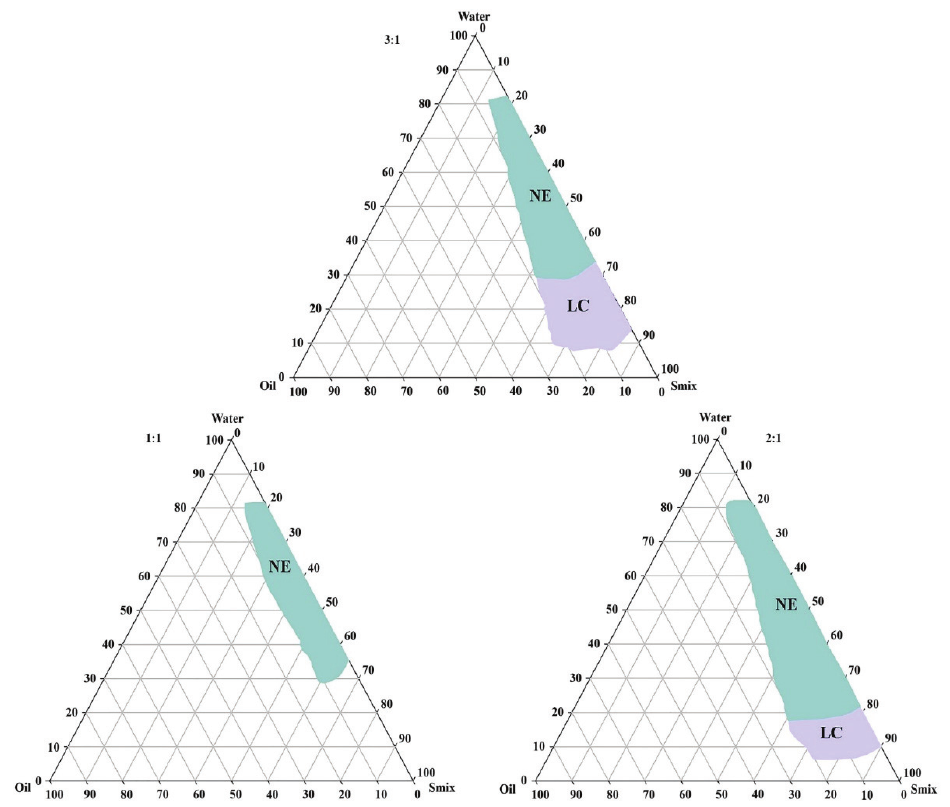
Figure 1. Pseudo-ternary phase diagrams demonstrating the influence of the Smix ratio (1:1, 2:1, and 3:1) on the nanoemulsion (NE) and liquid crystal (LC) regions. Table 2. Preformulation phase behavior study for the development of a retinyl palmitate- loaded